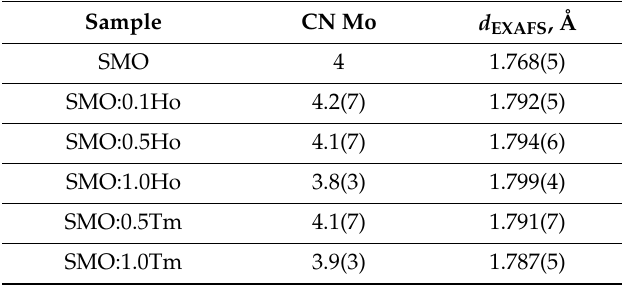
Table 5. The results of one-sphere EXAFS fit for strontium molybdate SrMoO 4 (SMO), SMO:Ho and SMO:Tm: coordination numbers (CN Mo) and Mo–O distances ( d EXAFS ,